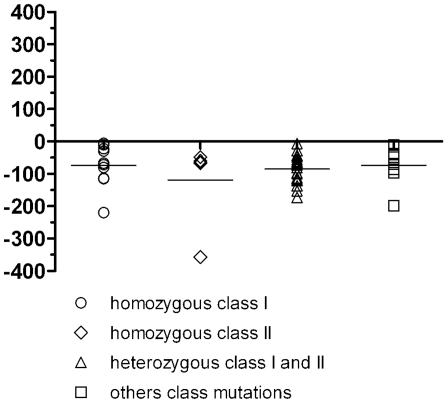
Distribution of CF-index by group of CFTR mutation.The CF subjects were categorized into 4 groups according to CFTR mutation. The five classes of CFTR mutation as described by Welsh and Smith [42] were adopted for this study according to the information available in the CFTR mutations database (http://www.genet.sickkids.on.ca/cftr/app). No significant differences were found between the mean values of CF-index in the 4 different genotype groups (homozygous class I, homozygous II, heterozygous class I and II and the other class mutations) on the basis of one-way ANOVA performed on normal scores computed on CF-index ranks.